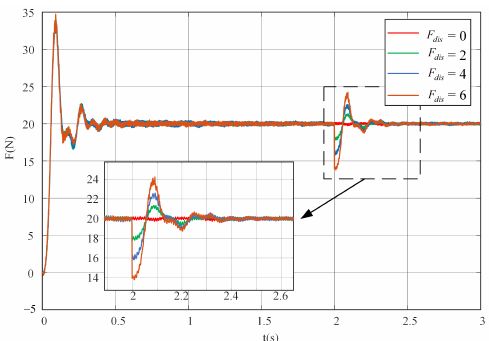
Figure 21. Robustness examination for